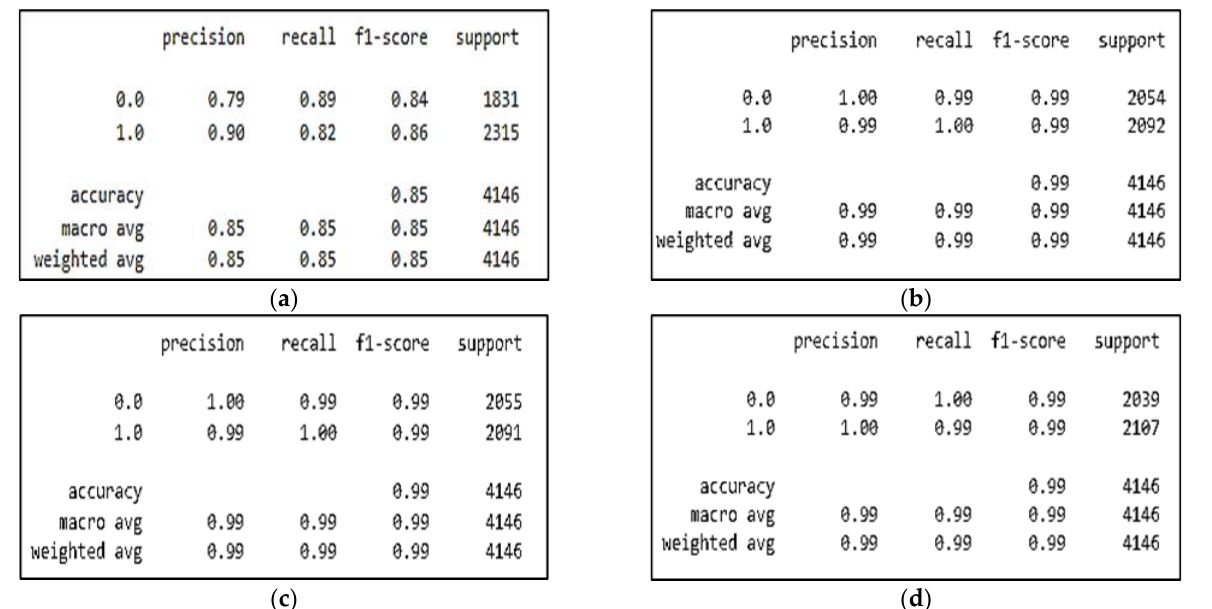
Figure 4. CNN model with/without AMs experiment results for: ( a ) CNN model; ( b ) CNN-SL model; ( c ) CNN-HD model; ( d ) CNN-SF model.